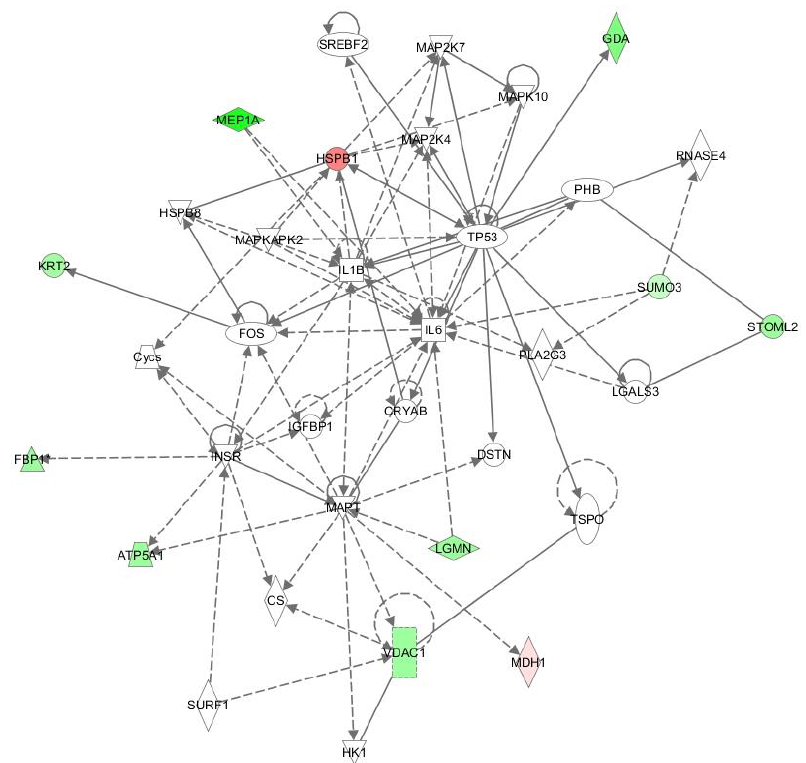
Figure 1. Ingenuity pathways analysis (IPA) functional network generated for data of NH0-, NH3-, and NH7-groups. Solid lines indicate direct interaction, dotted lines indicate indirect interaction. The identified proteins have in part direct (MEP1A), in part an adjacent influence on integrins (green/light green: up-regulation, red/light red: down-regulation).